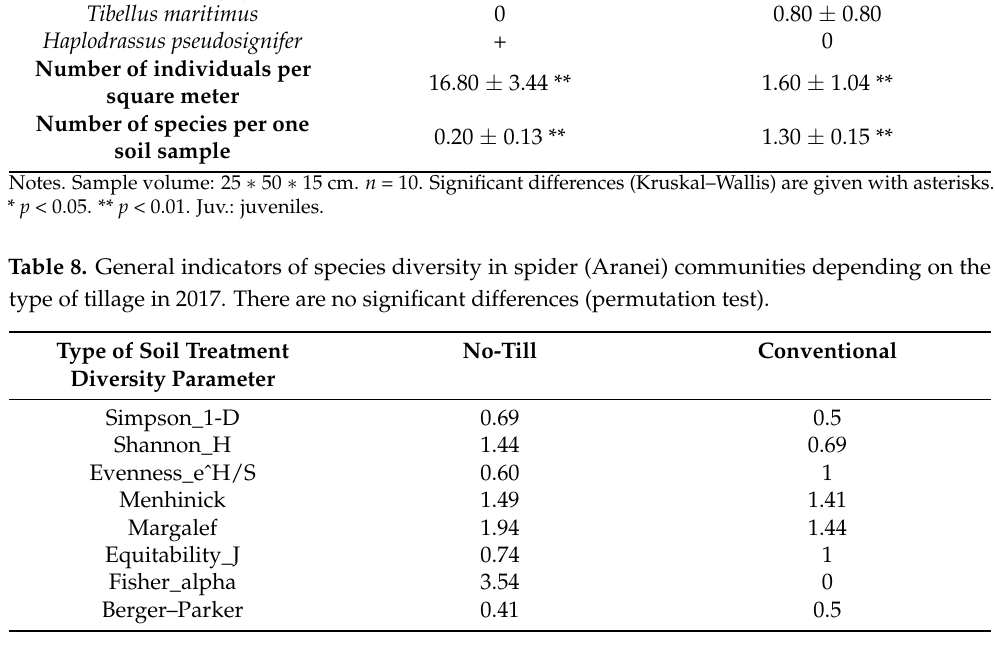
Table 9. Average dynamic density of spiders per trap on conventional and no-till plots in 2017 and 2018. Significant differences are given with asterisk. * p < 0.05; ± : standard